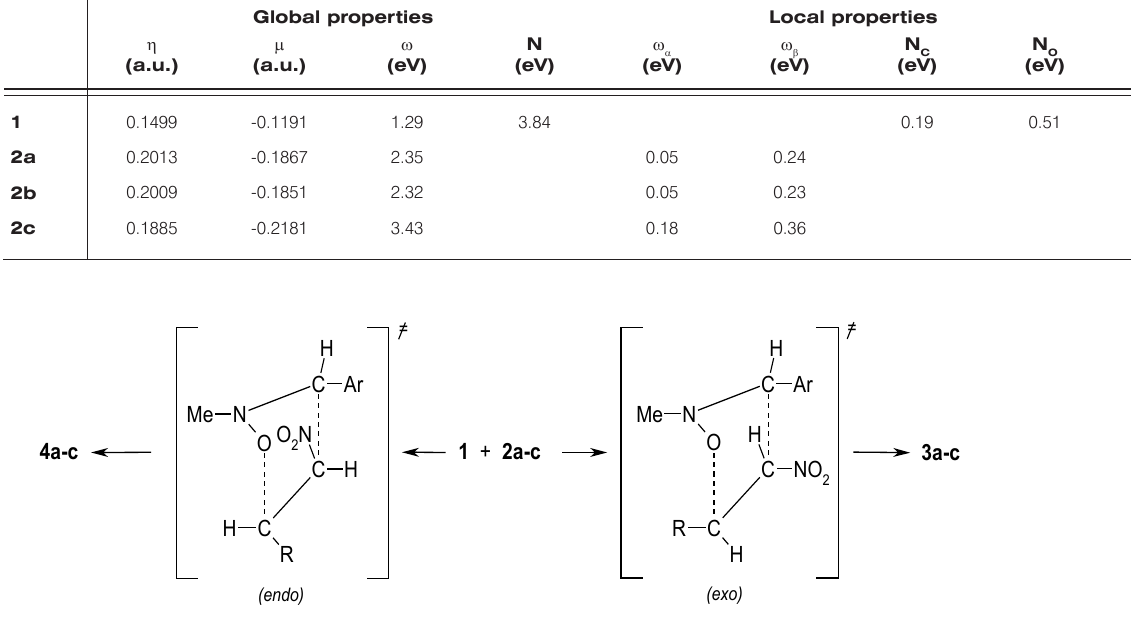
Table 1. Global and local electronic properties of nitrone 1 nitroalkenes 2a-c .